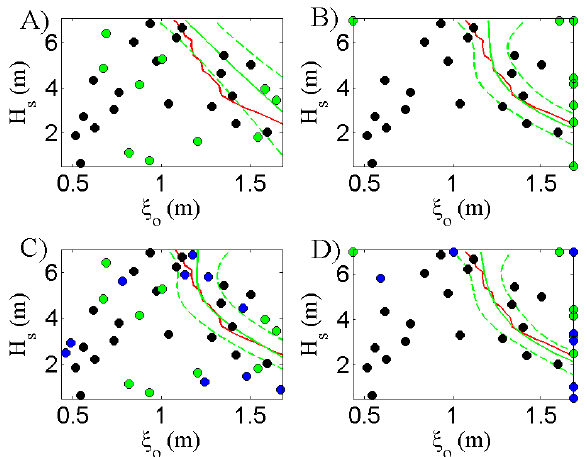
Fig. 7. Best estimate of sub-set of the four-dimensional 0 c (green Figure 7. Best estimate of sub-set of the four-dimensional  c (green solid line) in the {  o  H s } 3 solid line) in the { ξ o ; H s } domain defined for fixed T p =7s and domain defined for fixed T p =7s and  =135°N using a four-dimensional kriging model. The 4 θ =135 ◦ N using a four-dimensional kriging model. The corre- corresponding pair of contours at confidence level of 95% (defined as the kriging mean (Eq. 5 sponding pair of contours at confidence level of 95% (defined as the 2) +/- twice the square root of the variance (Eq. 3)) is represented by green dashed lines; The 6 kriging mean (Eq. 2) ± twice the square root of the variance (Eq. 3)) red solid line is the reference contour. A) Sampling strategy with no adaptive selection. The 7 is represented by green dashed lines; the red solid line is the refer- training data is composed of an initial budget of 20 samples (black dots) and 10 additional 8 ence contour. (A) Sampling strategy with no adaptive selection. The samples (green dots); B) Sampling strategy with adaptive selection. The number of samples in 9 training data are composed of an initial budget of 20 samples (black dots) and 10 additional samples (green dots); (B) sampling strategy is identical to A); C) Sampling strategy with no adaptive selection. The training data 10 with adaptive selection. The number of samples in (B) is identi- correspond to the one of A) completed by 10 additional training data (blue dots); D) Sampling 11 cal to (A) ; (C) sampling strategy with no adaptive selection. The strategy with adaptive selection. The training data correspond to the one of B) completed by 12 training data correspond to the one of (A) completed by 10 addi- 10 additional training data (blue dots). 13 tional adaptively selected training data (blue dots); (D) sampling strategy with adaptive selection. The training data correspond to the one of (B) completed by 10 additional adaptively selected training data (blue